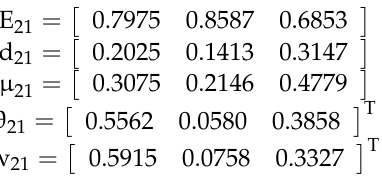
Table 3. Division of evaluation sets.